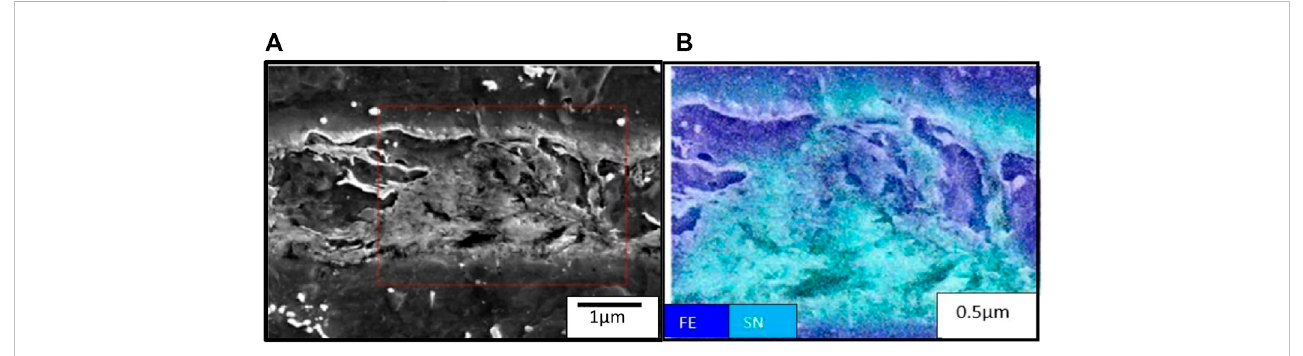
FIGURE 10 (A) SEM micrograph and (B) EDS mapping of the selected area.